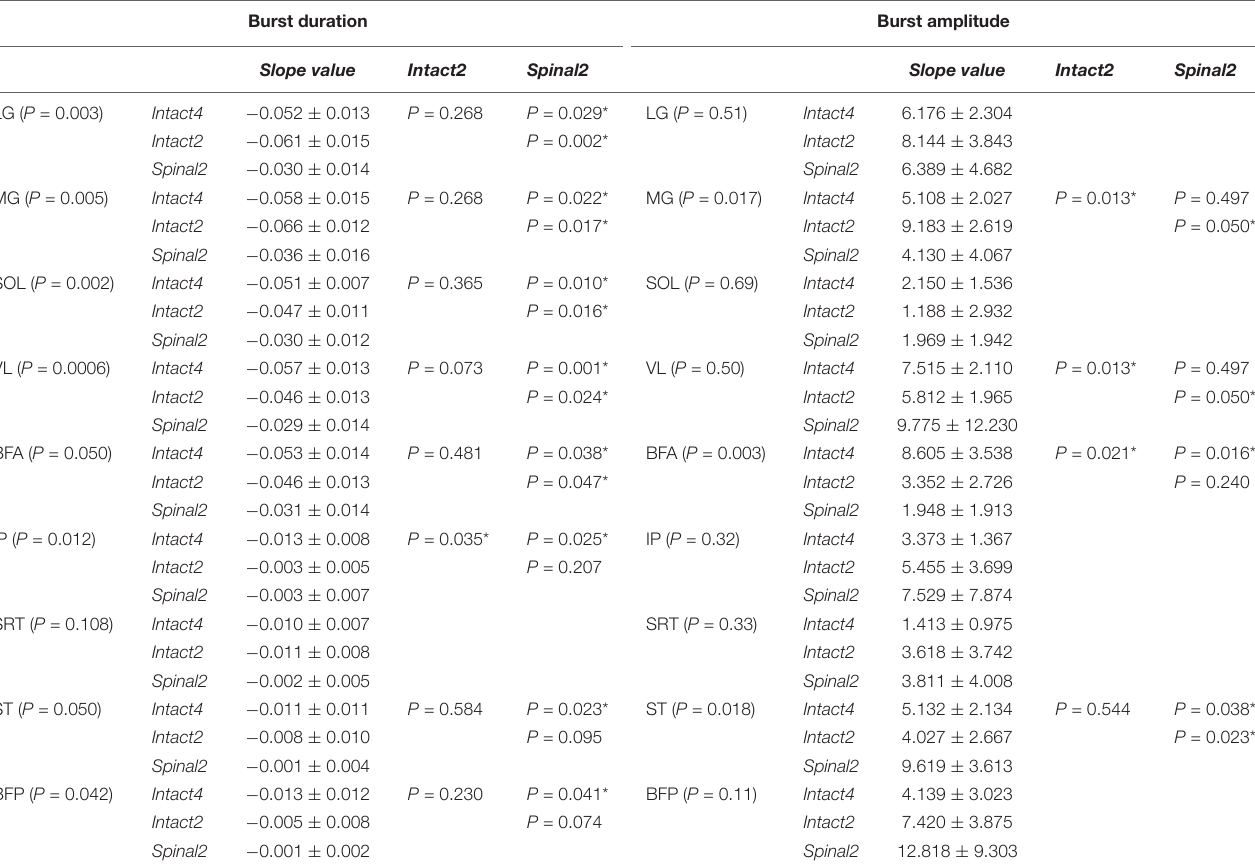
TABLE 2 | Effect of speed on EMG burst durations and amplitudes in the three